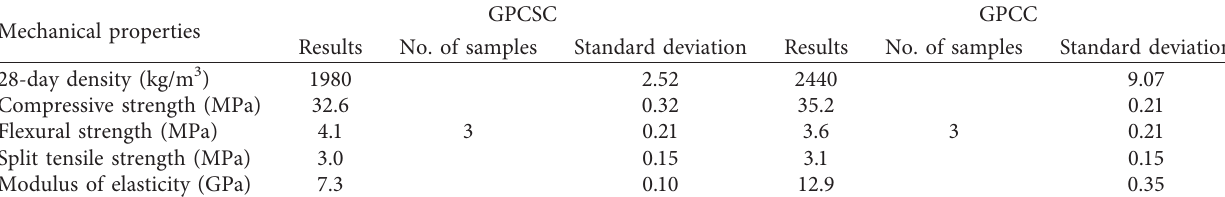
Table 3: Properties of geopolymer concrete.